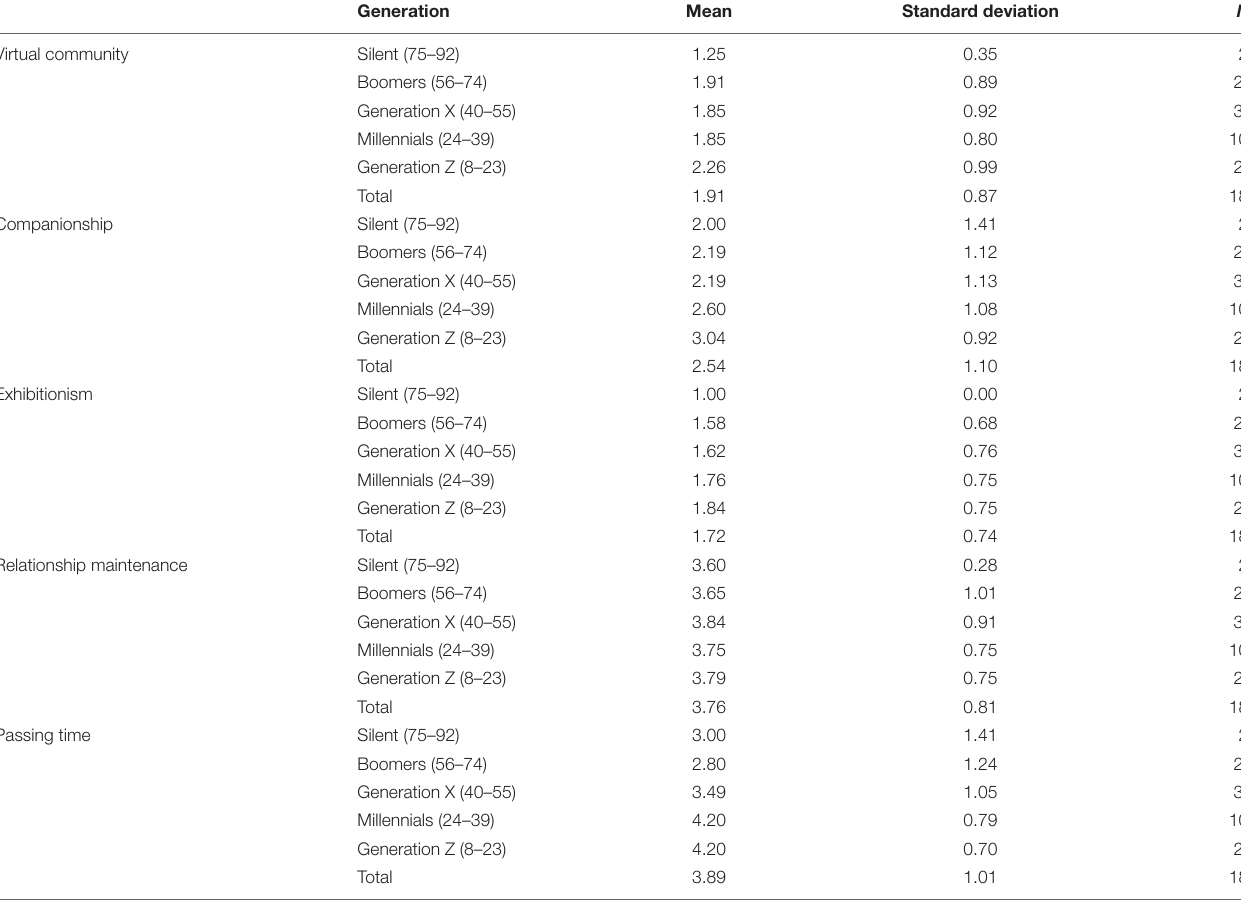
TABLE 3 | Descriptive statistics for generational motives.